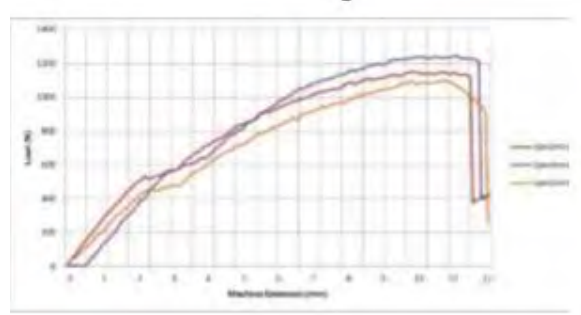
Figure 37. Graphs of the apparent Modulus of Elasticity of span 280 mm (Author’s own, n.d.)